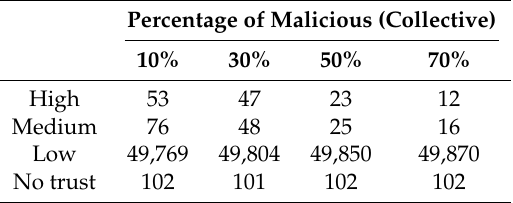
Figure 12. Service time with 10% of malicious. Table 10. Feedback reliability result with feedback malicious